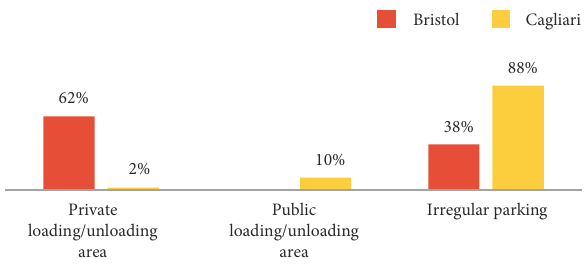
Figure 10. Location of vehicle for loading/unloading